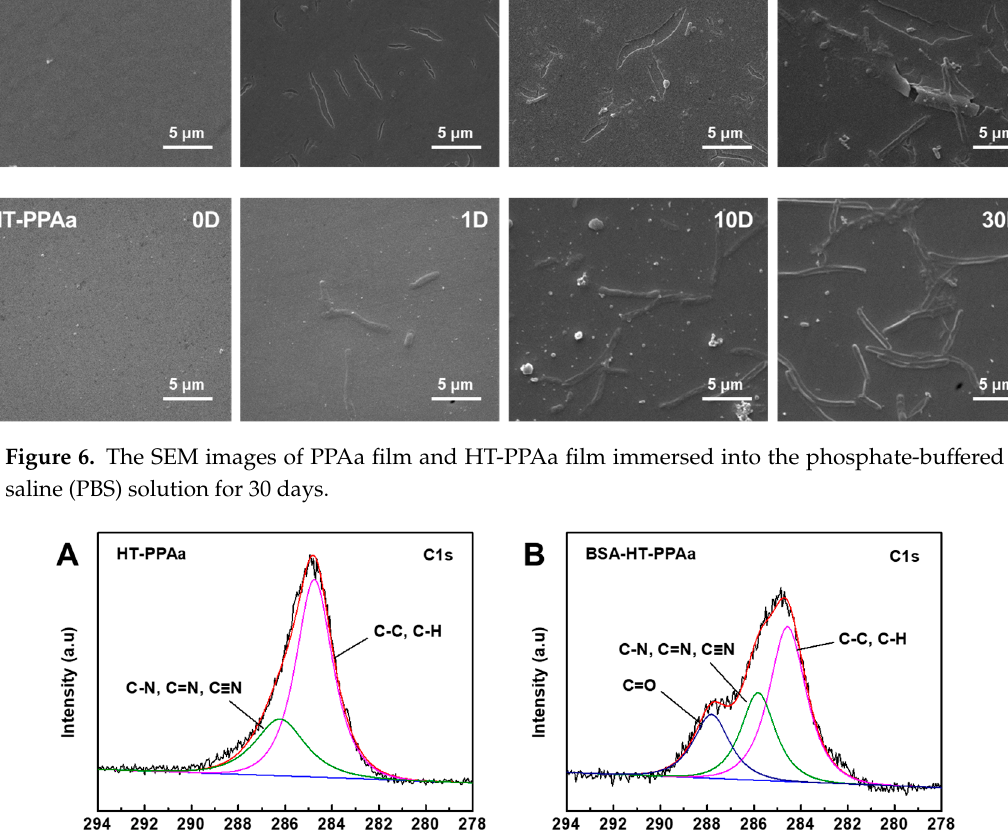
Figure 6. The SEM images of PPAa film and HT-PPAa film immersed into the phosphate-buffered saline (PBS) solution for 30 days.